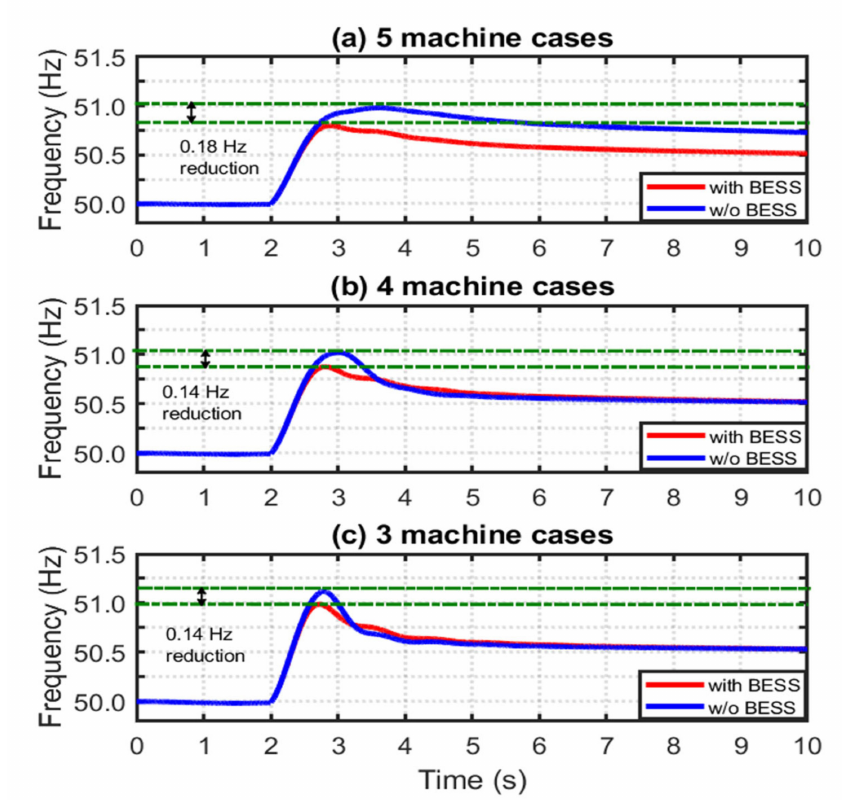
Figure 18. Performance comparison due to 450-MW interconnection trip: ( a ) five-machine case; ( b ) four-machine case; ( c ) three-machine